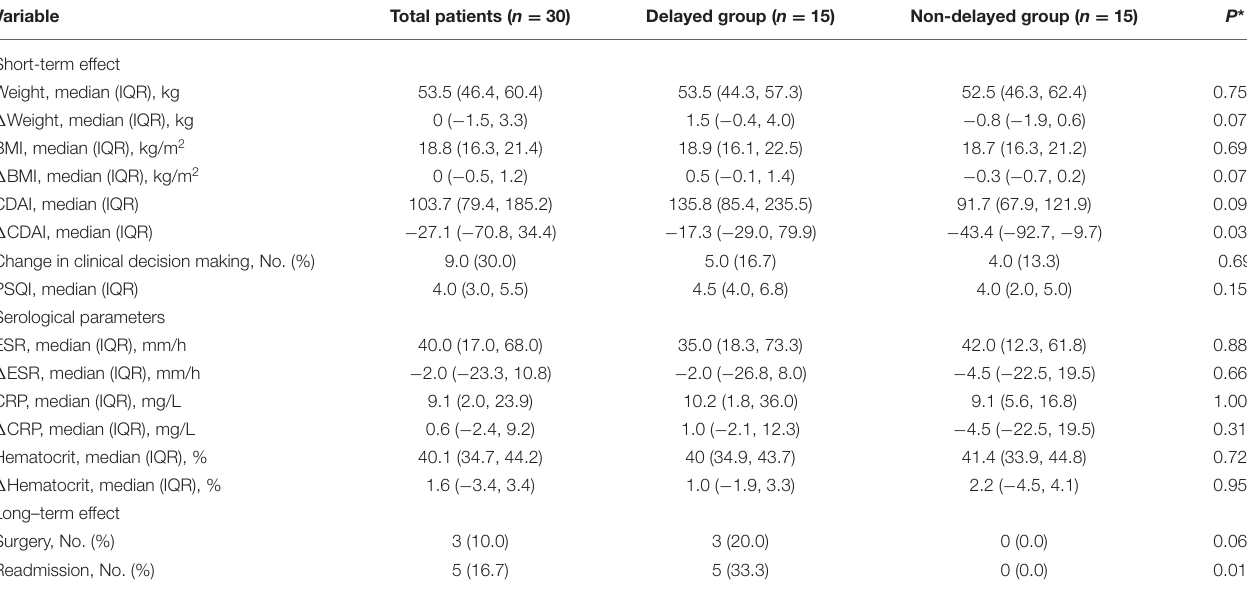
TABLE 4 | The comparison of the effect of delayed treatment between both groups after propensity score-matched analysis.